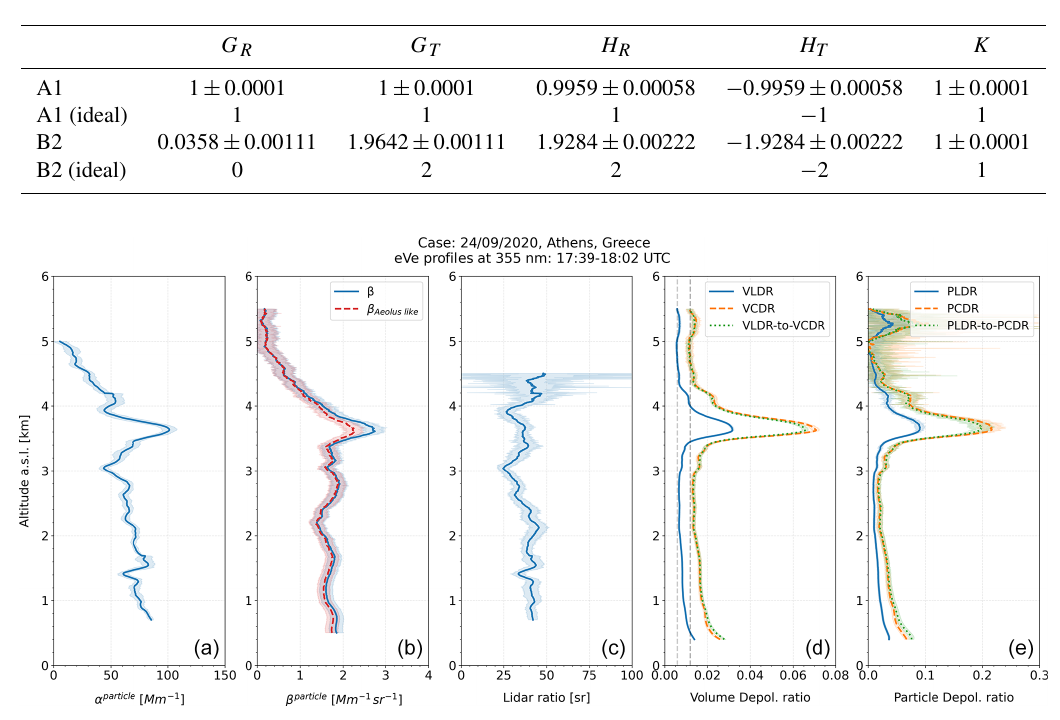
Figure 11. Profiles of the particle extinction coefficient, the particle backscatter coefficient, the lidar ratio, the volume depolarisation ratios and the particle depolarisation ratios (from left to right) at 355nm for the time frame 17:39 to 18:02UTC on 24 September 2020. The Aeolus-like particle backscatter coefficient ( β Aeolus-like ; dashed red line) and the particle backscatter coefficient ( β ; solid blue line) were both retrieved from the circularly polarised signals of eVe lidar using the Raman inversion method where the reference height for Rayleigh atmosphere was selected at 9.8km within a 0.2km window. The VLDR and PLDR profiles are presented by solid blue lines, the VCDR and PCDR profiles are presented by dashed orange lines, while the VLDR-to-VCDR and PLDR-to-PCDR profiles are presented by dotted green lines. The corresponding mLDR and mCDR values (dashed grey lines) that are expected to be measured by the lidar are also provided in the volume depolarisation ratio subplot. Shaded regions denote statistical 1 σ